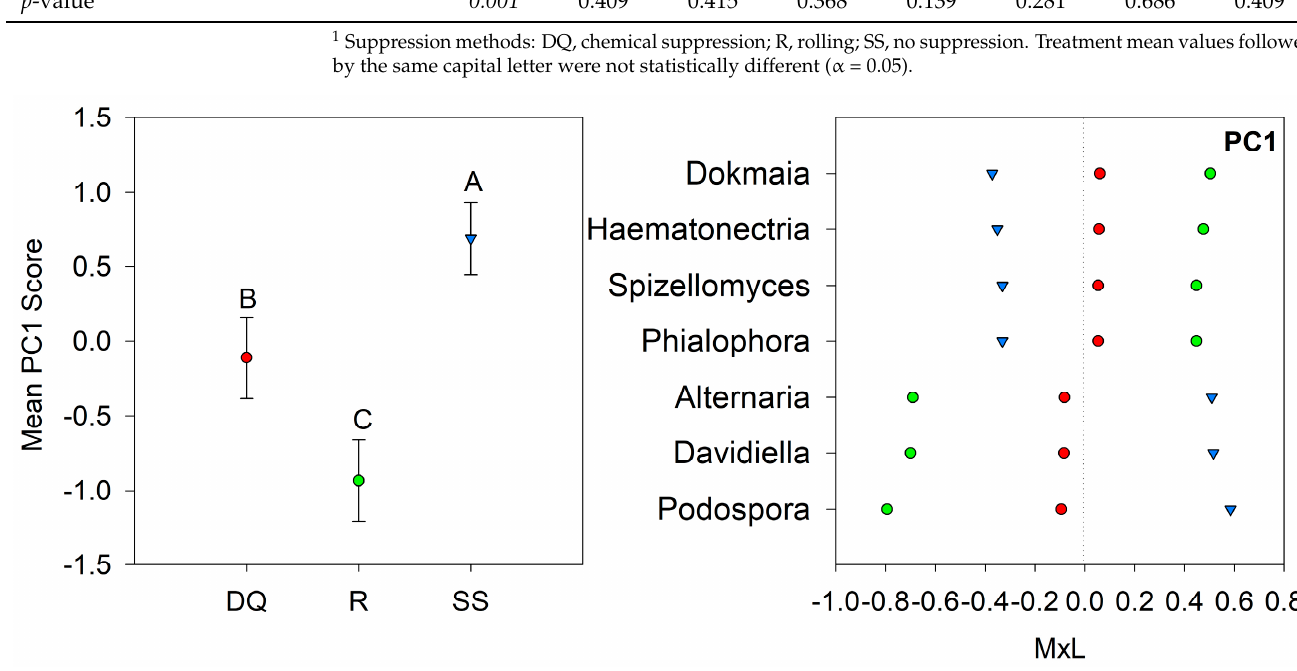
Figure 5. Visual representation of the combined results of the principal component analyses (PCAs) and their mean separation procedure showing the genera with loadings >|0.45| according to Supplementary Table S4 for PC1: ( a ) Mean values of the PC1 scores for each suppression method with their standard errors (as error bars). Different capital letters indicate significant differences between suppression method ( p < 0.05); ( b ) Contribution of each indicator genera to the PC1 mean value (Table 5) for each suppression method (DQ, red circles: chemical suppression; R, green circles: rolling, and SS, blue triangles: no suppression) multiplied by the loading of the specific genera within the PC (Table S4), named M ×